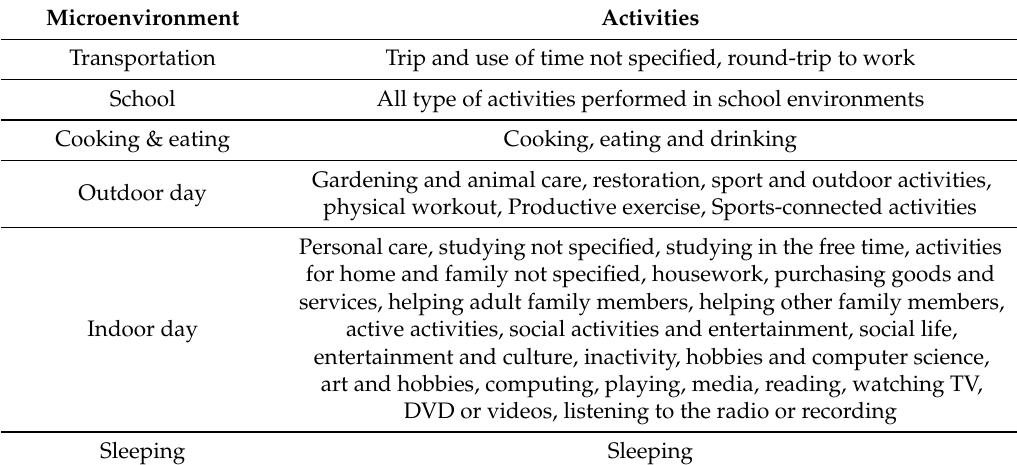
Table 2. Classification of the activities performed by the citizens in seven main